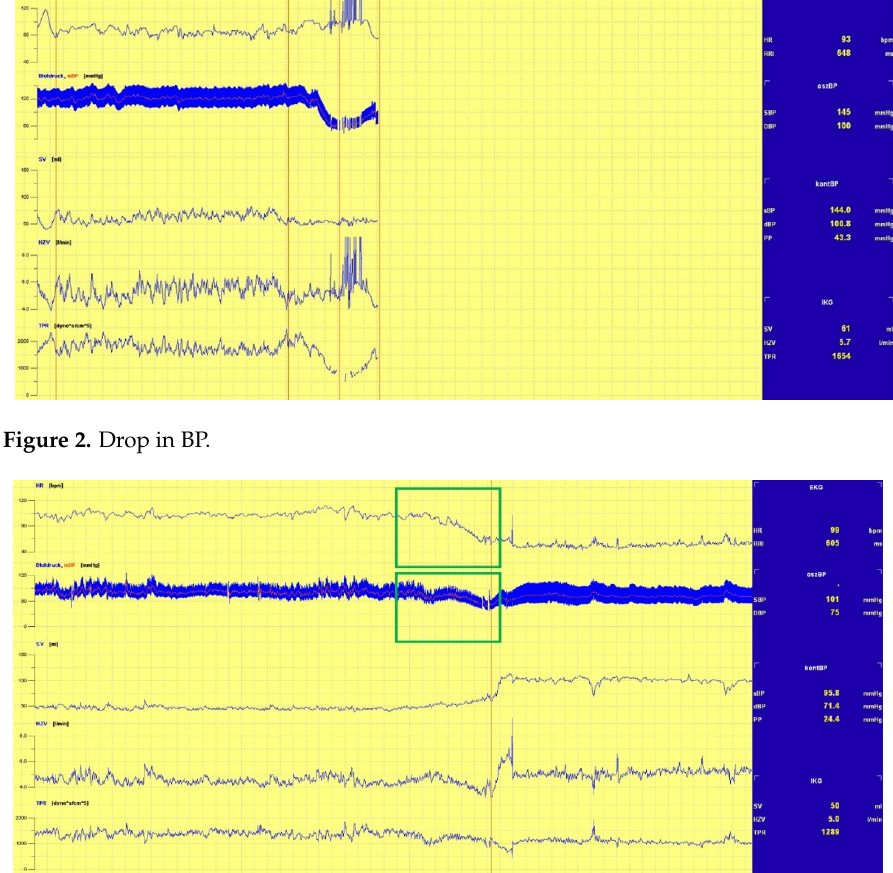
Figure 3. Drop in both BP and HR.